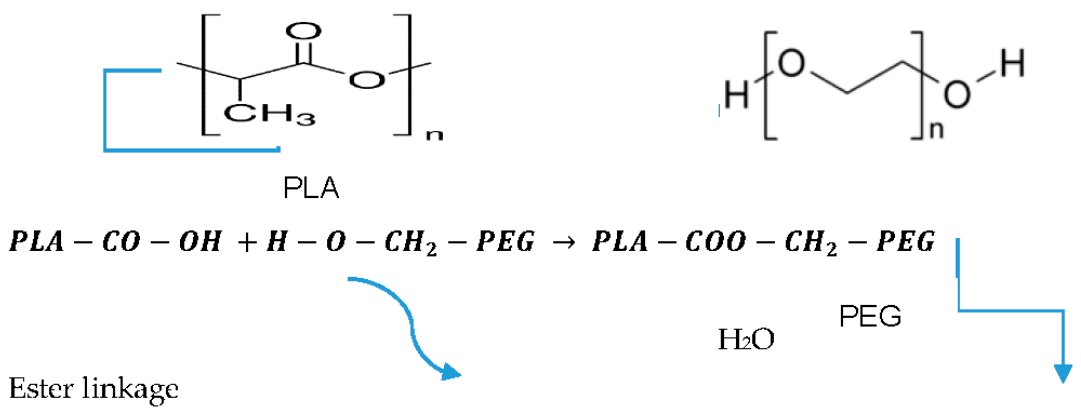
Figure 5. Transesterification reaction of PLA and PEG.